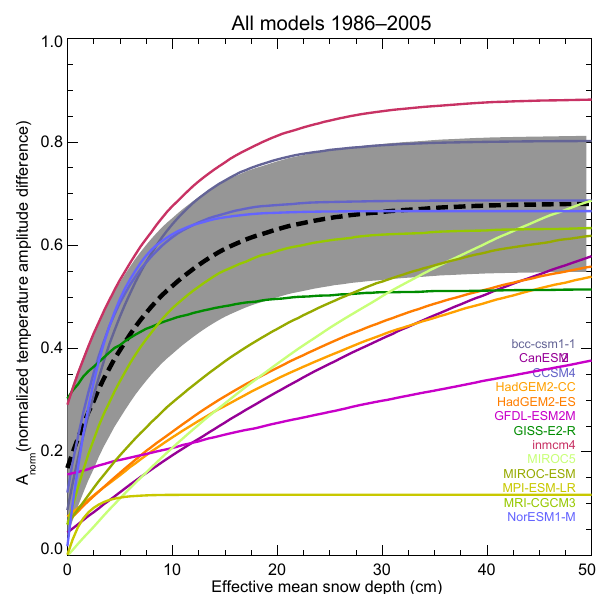
Figure 4. Model fits to Eq. (5), showing large differences in how heat is transferred though the snowpack to the soil. Data from the CMIP5 comparison period 1986–2005 are used. The dashed black line is the observational fit, with grey shading representing the ob- servational scatter as in Fig.